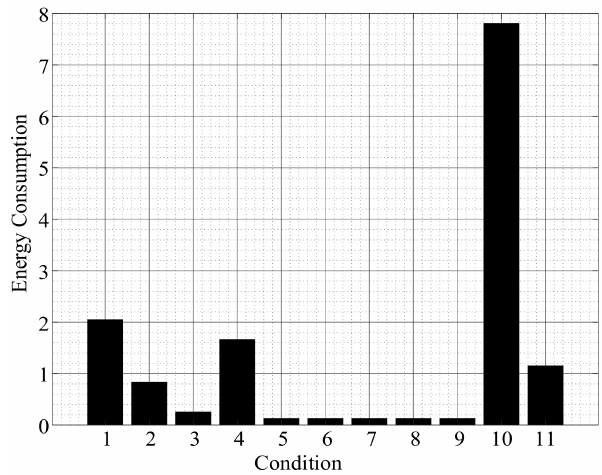
Figure 7. Energy for fourth line condition.